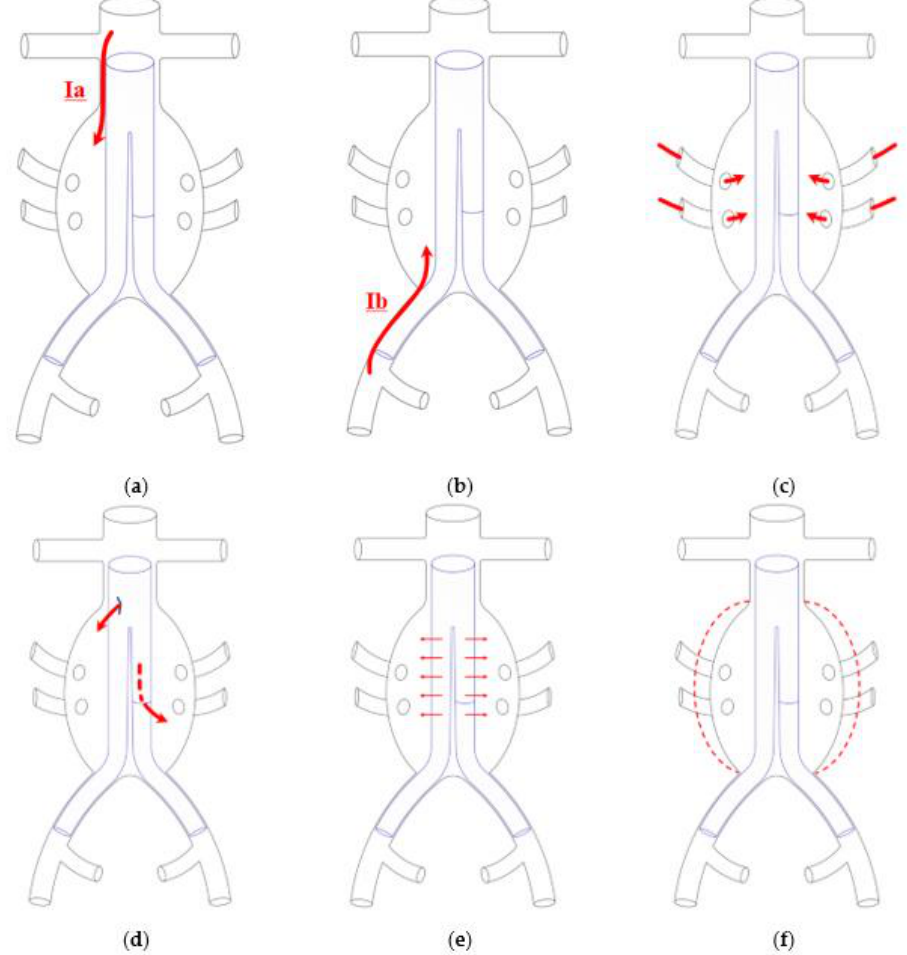
Figure 1. Schematic representation of endoleak types. ( a ) Type Ia endoleak (ELIA), originating from the proximal end of the stent-graft; ( b ) Type Ib endoleak, originating from the distal end of the stent-graft; ( c ) Type II endoleak, originating from retrograde flow from the inferior mesenteric artery or lumbal arteries; ( d ) Type III endoleak, due to stent-graft component disconnection or fabric tear; ( e ) Type IV endoleak, due to stent-graft material porosity; ( f ) Type V endoleak, due to unidentified source, sac expansion without visible any visible leak.